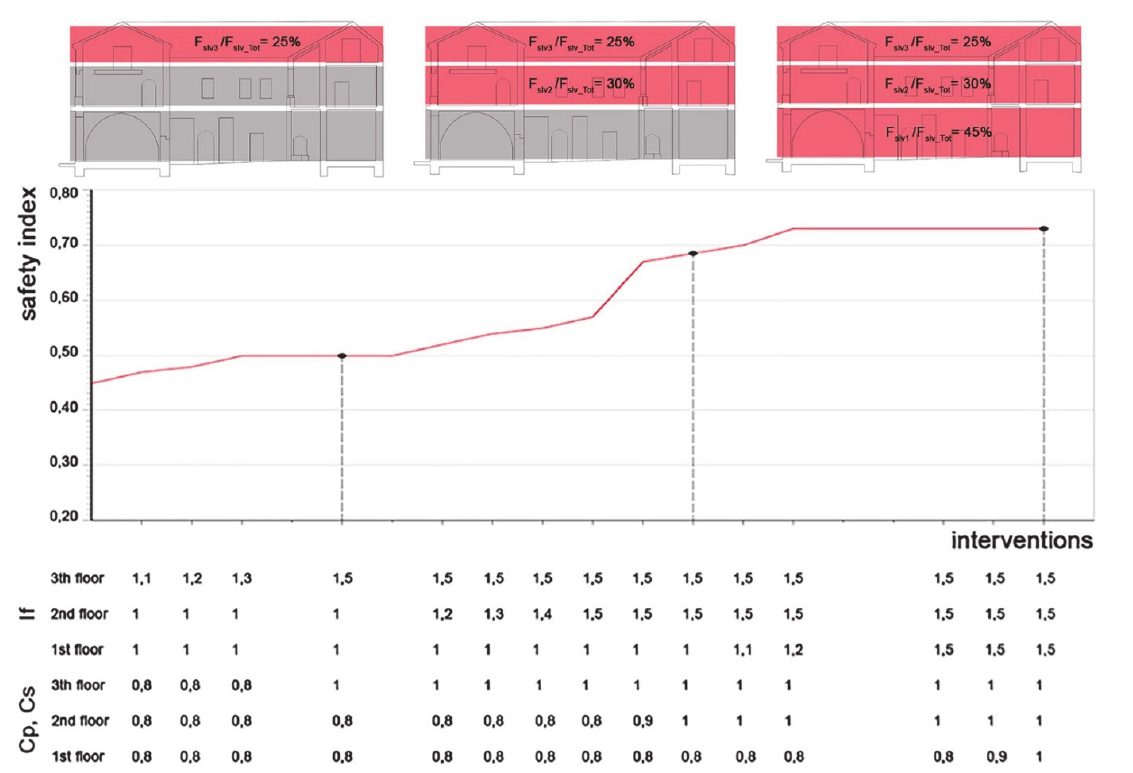
Figure 10: Safety index curve of “Palazzo Petrucci